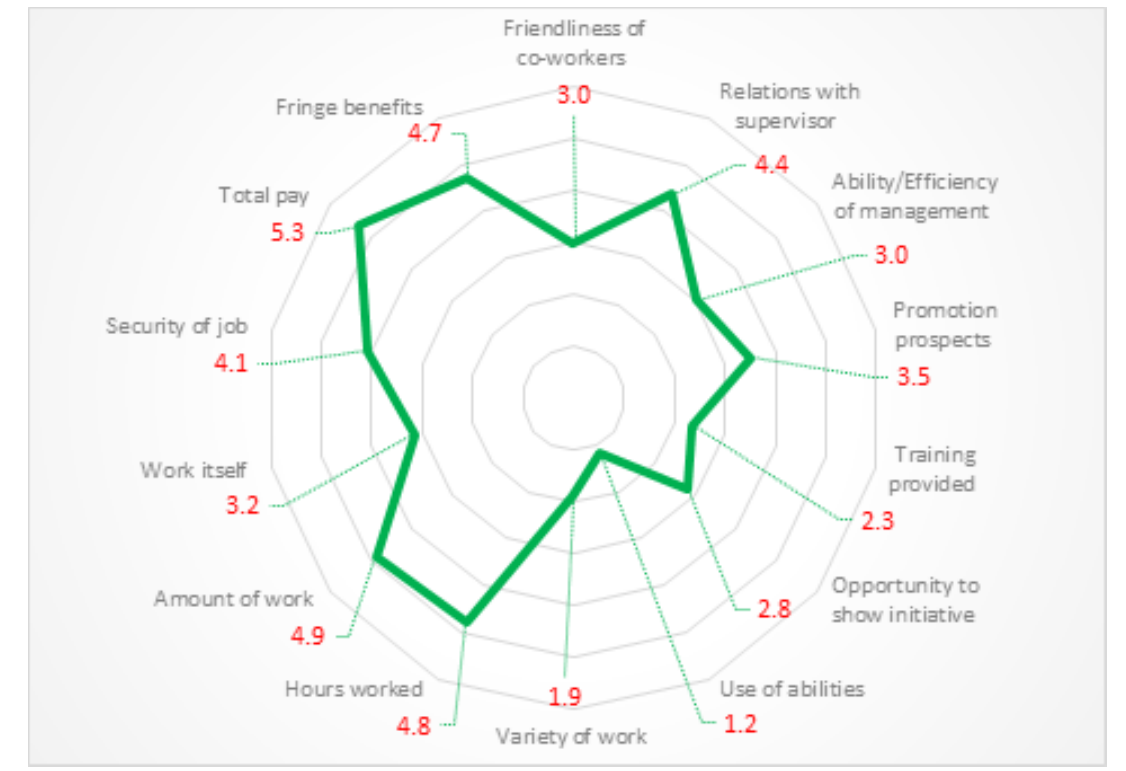
Figure 1. Prioritization of employee motivations — sample average (1 – 7-point scale).